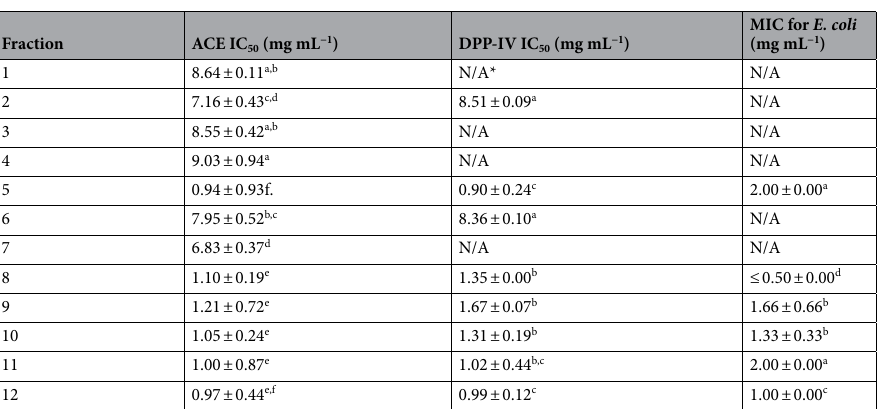
Table 5. Biological activities of gelatin hydrolysate fractions obtained by reverse-phase high-performance liquid chromatography. Data are shown as mean ± standard error of three replicates. Different superscript letters in the same column represent significant differences ( P < 0.05). ACE, angiotensin-converting enzyme; DPP-IV, dipeptidyl peptidase IV; IC 50 , half maximal inhibitory concentration; MIC, minimum inhibitory concentration; N/A, means not